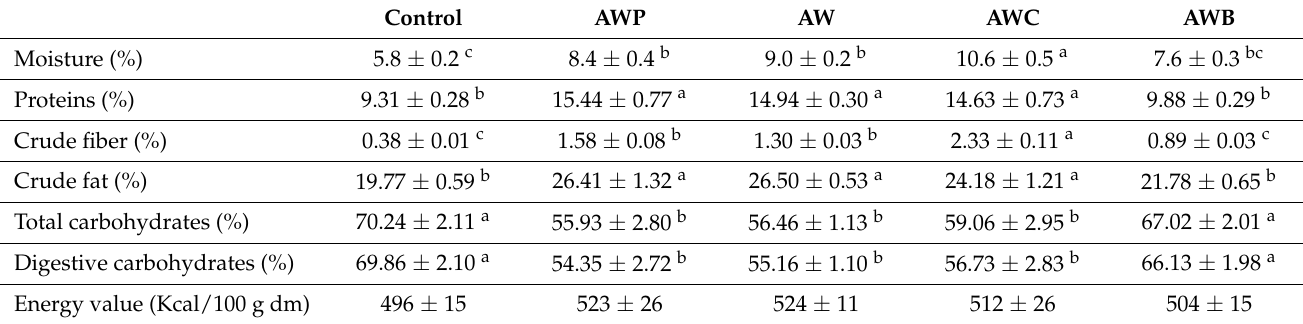
Table 6. Proximate composition of cookies elaborated with flours and oil from nuts and seeds. Control AWP AW AWC